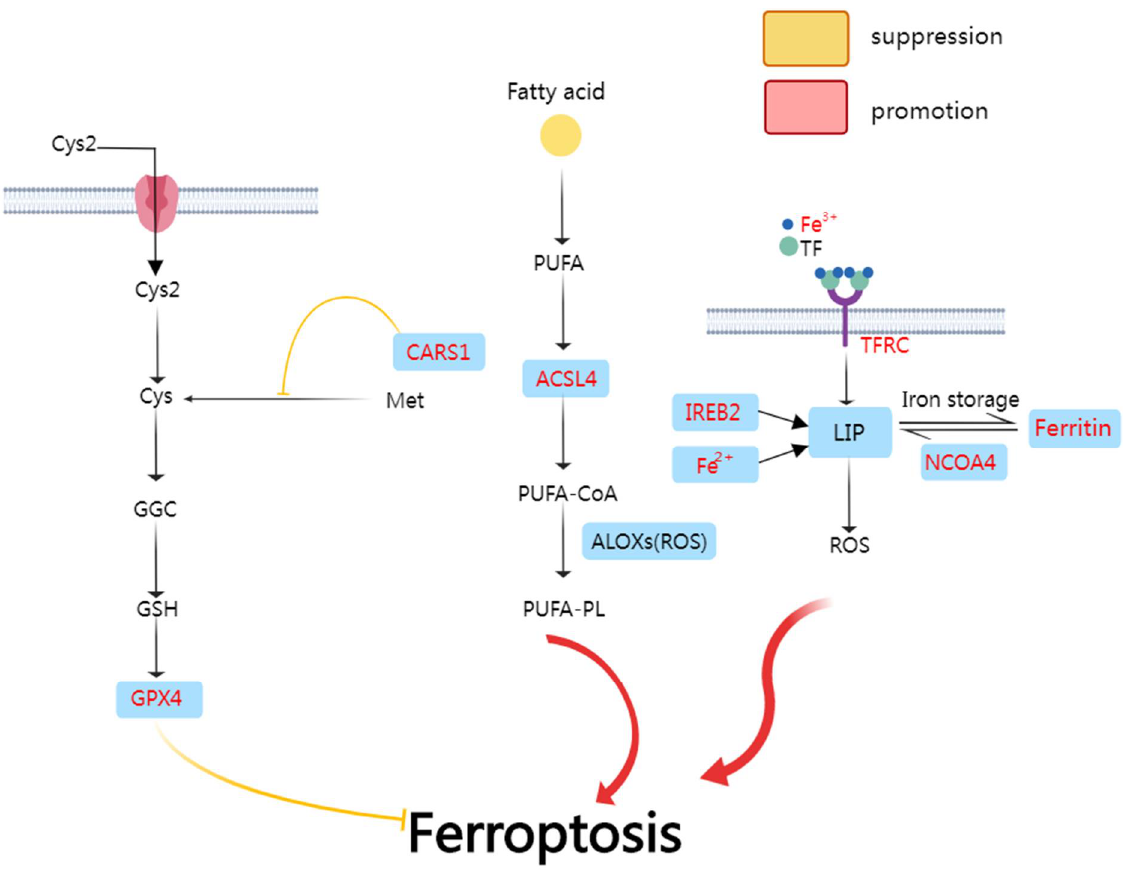
Figure 2. Schematic diagram of ferroptosis pathway.